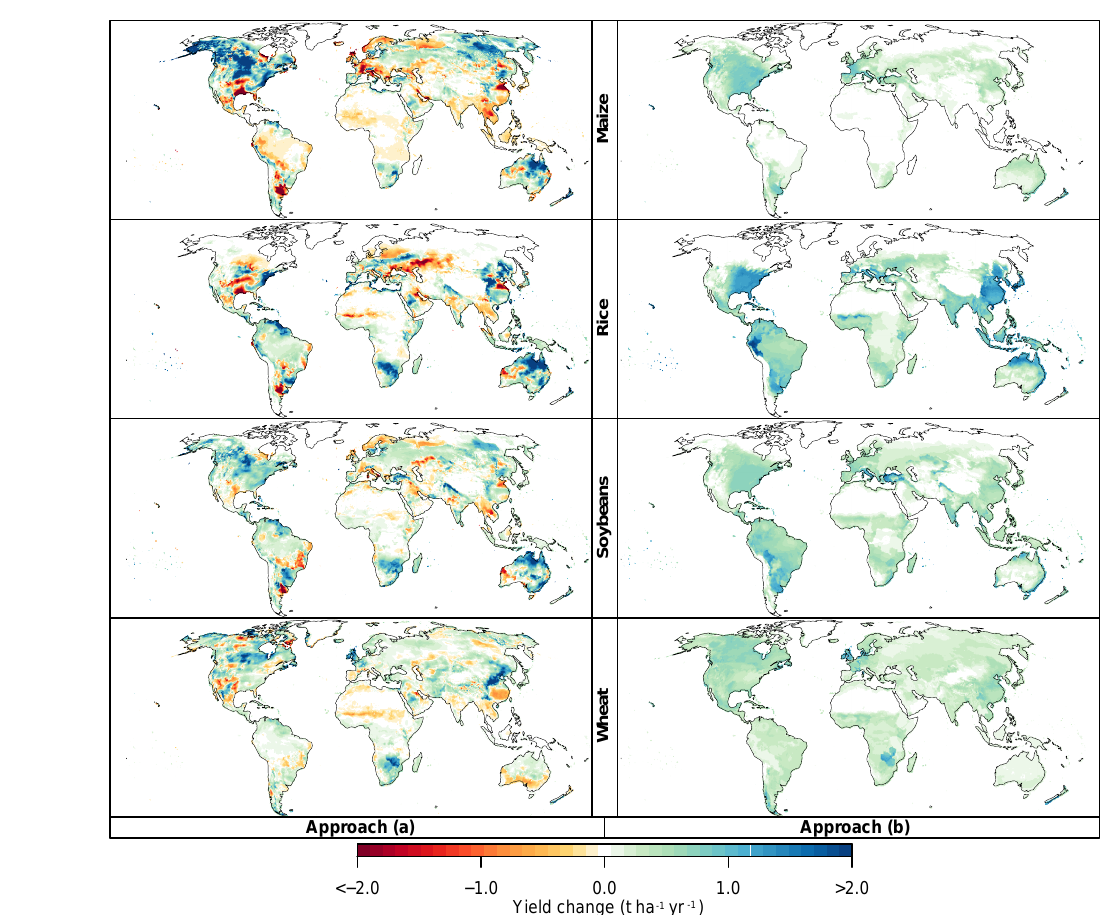
Figure 7. CO 2 -induced yield changes at 2.5 ◦ C of global warming for LPJmL forced by HadGEM2-ES assuming rain-fed conditions. Analogous to Fig. 6, but showing the scaling coefficients a 1 ( i ) from approach (a) (left column panels) and approach (b) (right column panels), multiplied by the average p CO 2 change compared to the year 2000 (370ppm) across all years falling into the GMT bin. Rows: different crop types. Analogous figures for irrigated conditions, for different GGCMs, and using relative instead of absolute yield changes are available in the